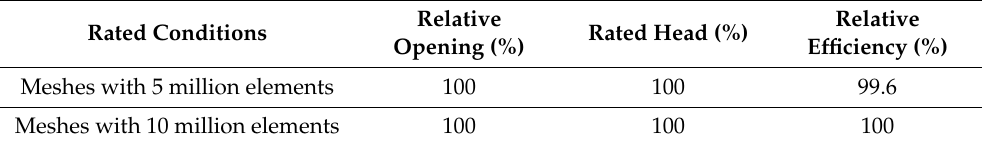
Table 2. Mesh independence test.